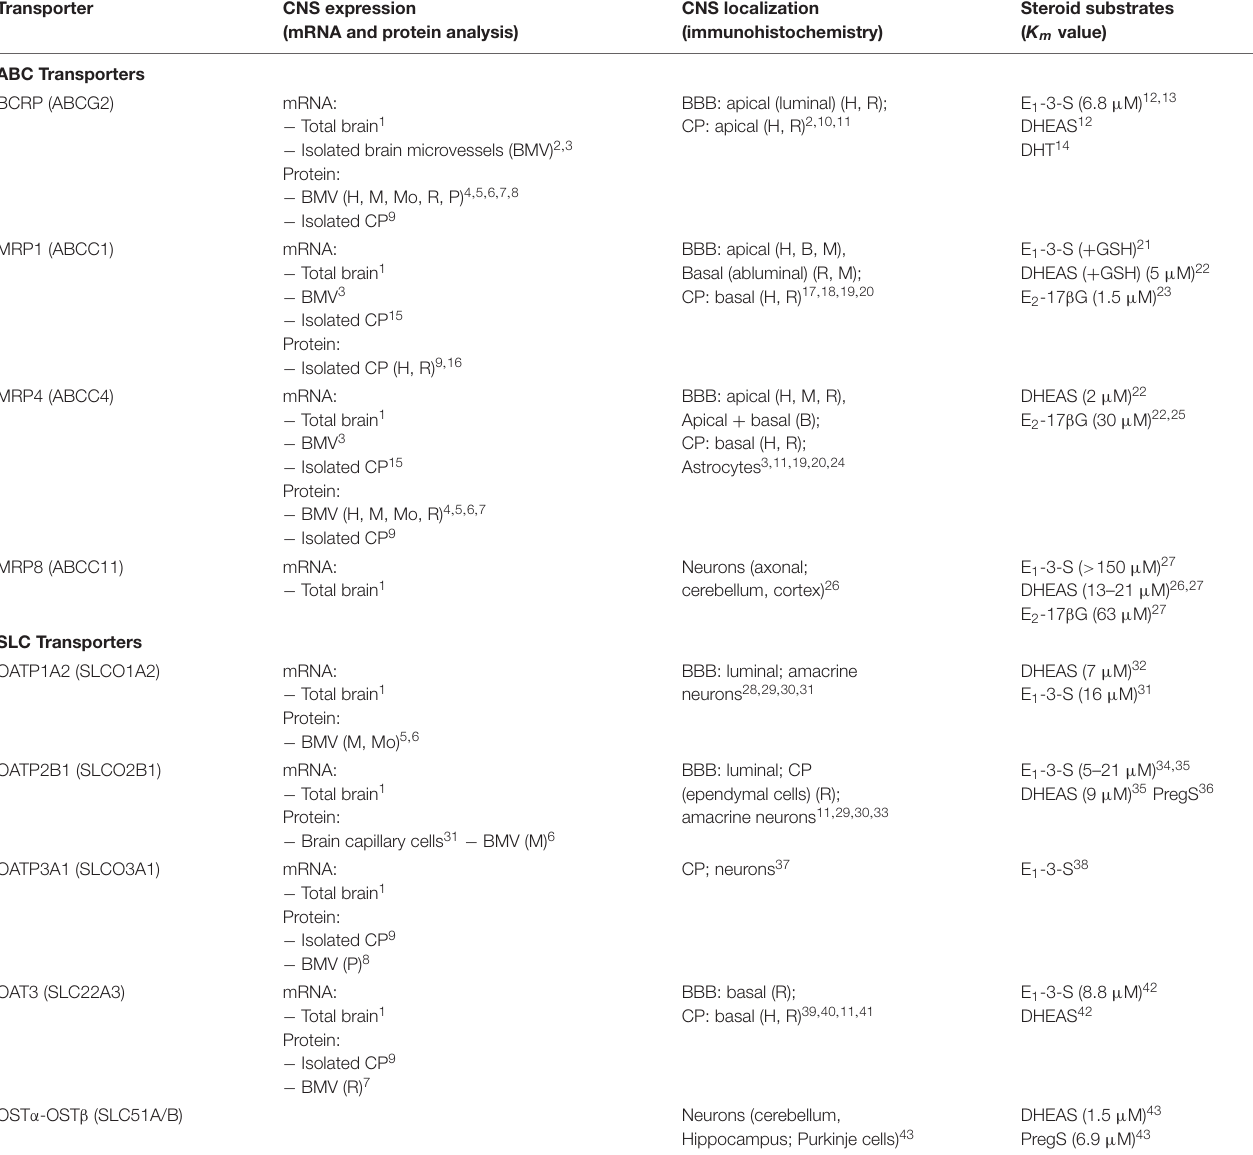
TABLE 1 | ABC and SLC transporters possibly involved in neurosteroid transport in the brain. Transporter CNS expression